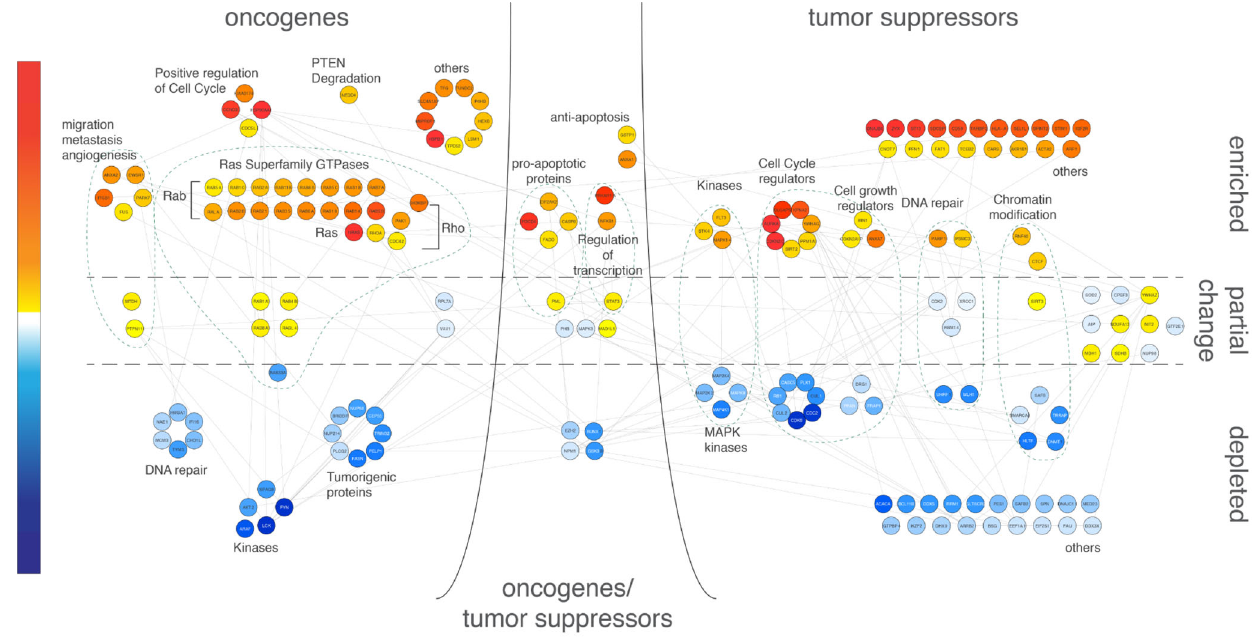
Figure 4. Both beneficial and detrimental effects of Hsp90 inhibitors on cancer-related proteins. Cancer proteins categorized by Higgins et al. [46] as oncogenes or tumour suppressors were retrieved and identified in the stSILAC data. These results were further refined and confirmed by literature mining, and organized in a protein-protein interaction network. Relative levels of proteins at 20hs after GA treatment are integrated in the graph and represented by the same colour gradient as in Fig. 2.